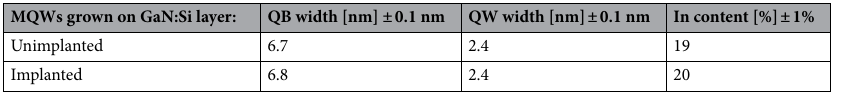
Table 1. Calculated thickness of the QBs and QWs and also In content based on HRXRD data.